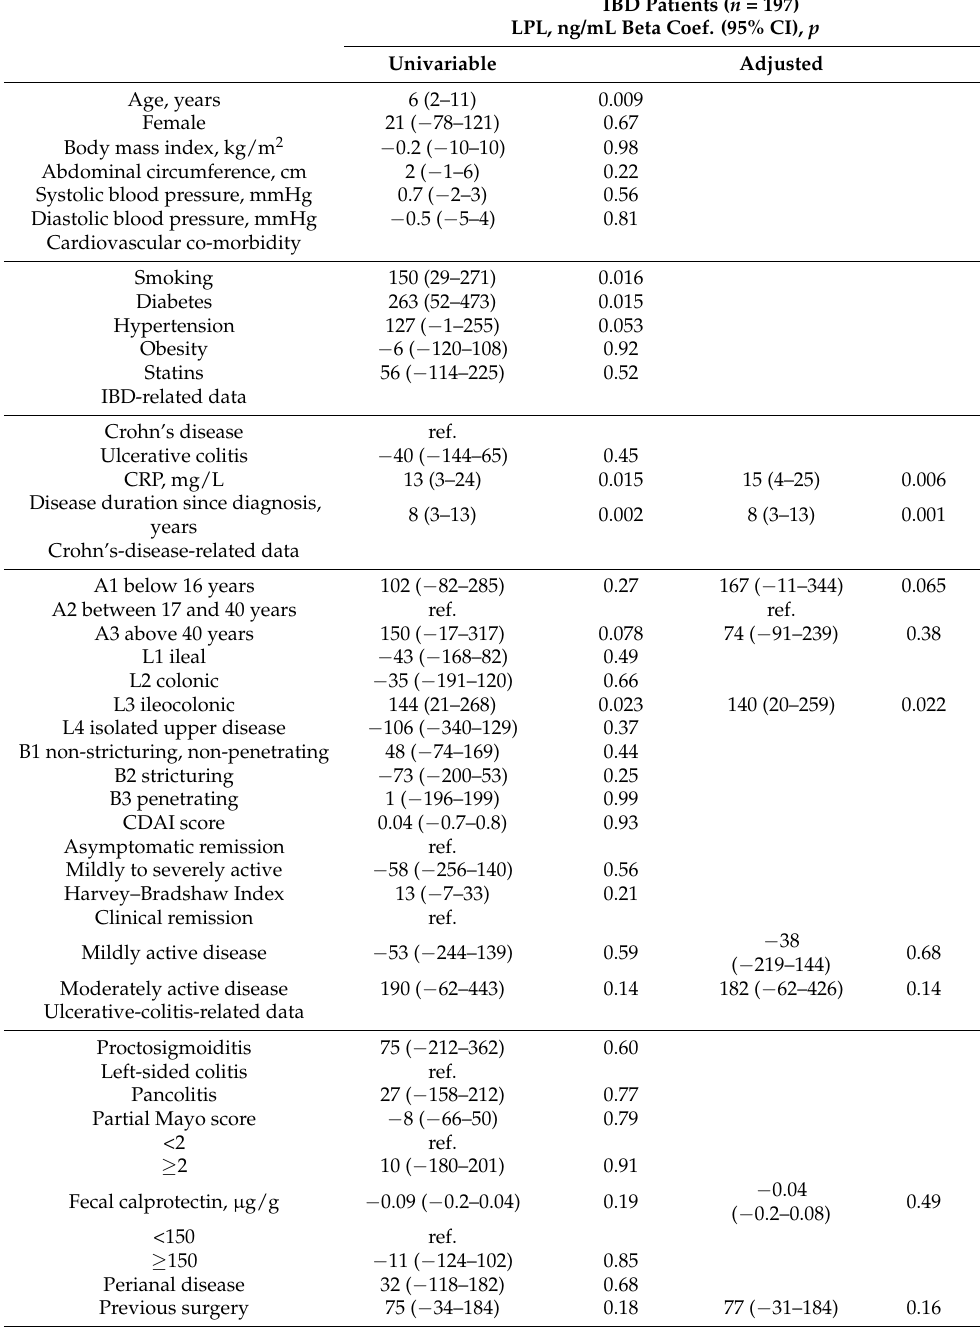
Table 2. Relation of demographics and disease-related data to lipoprotein